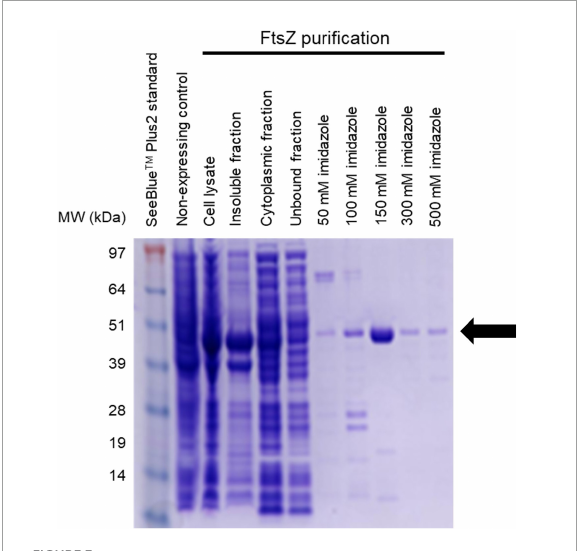
FIGURE3 Purification of Ab FtsZ Ab FtsZ was cloned in the pET-41a(+) vector and expressed in BL21(DE3) E. coli via induction with 1 mM IPTG. The protein was purified from the cytoplasmic fraction using Nickel-affinity column chromatography. The different fractions from the purification process were loaded onto SDS-PAGE (4–12%). Protein was visualized by staining with Coomassie R (cid:13) Brilliant Blue R-250. Purified Ab FtsZ (43.4 kDa) is observed as indicated by the arrow. The protein concentration was determined using the standard Bio-Rad TM BCA Protein Assay